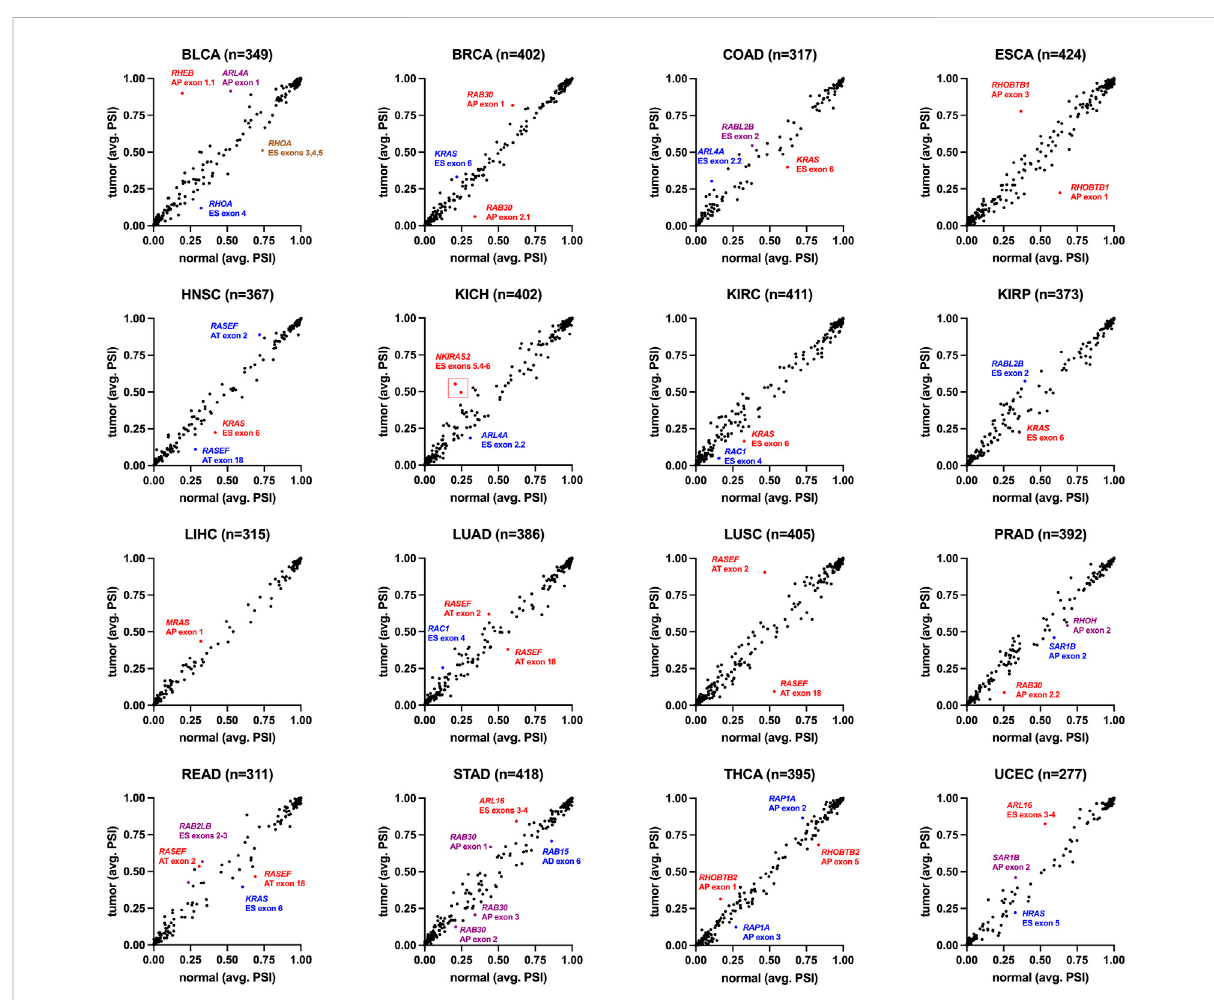
FIGURE 13 Small GTPase splicing dynamics in human cancer. Percent-spliced-in (PSI) values are the normalized read counts for inclusion of the splicing event over the normalized total (inclusion and exclusion) read counts for that event. The small GTPase splice isoforms were selected, and their PSI values averaged for all normal ( x -axis) and tumor tissue ( y -axis) within the indicated cancer types: BLCA-bladder urothelial carcinoma (19 cases/ 416 controls), BRCA-invasive breast carcinoma (113/1104), COAD-colon adenocarcinoma (41/467), ESCA-esophageal carcinoma (13/190), HNSC- head and neck squamous cell carcinoma (43/511), KICH- kidney chromophobe (25/76), KIRC- kidney renal clear cell carcinoma (72/543), KIRP- kidney renal papillary cell carcinoma (32/300), LIHC- liver hepatocellular carcinoma (50/381), LUAD-lung adenocarcinoma (59/524), LUSC- lung squamous cell carcinoma (49/511), PRAD-prostate adenocarcinoma (52/507), READ-rectum adenocarcinoma (10/176), STAD-stomach adenocarcinoma (37/425), THCA-thyroid carcinoma (71/527), UCEC- uterine corpus endometrial carcinoma (35/555). Listed for each cancer type is the number of isoforms in small GTPases (n). Select splice isoforms are indicated by gene, exon(s), and type of event (AP, alternate promoter; AT, alternate terminator; ES, exon